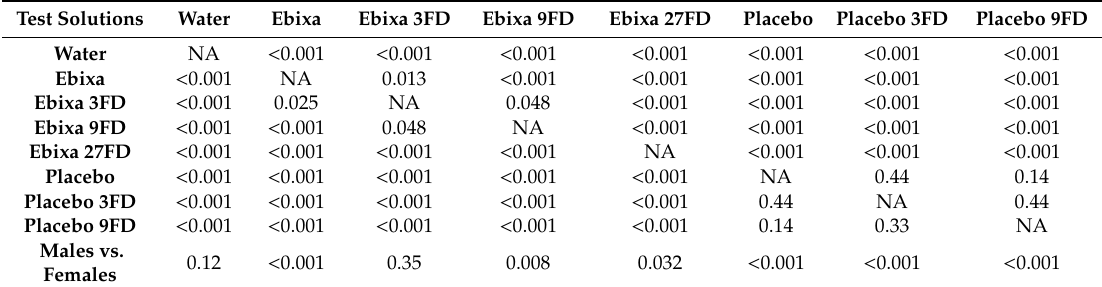
Table 2. Non-parametric statistical testing to compare lickometer results between test